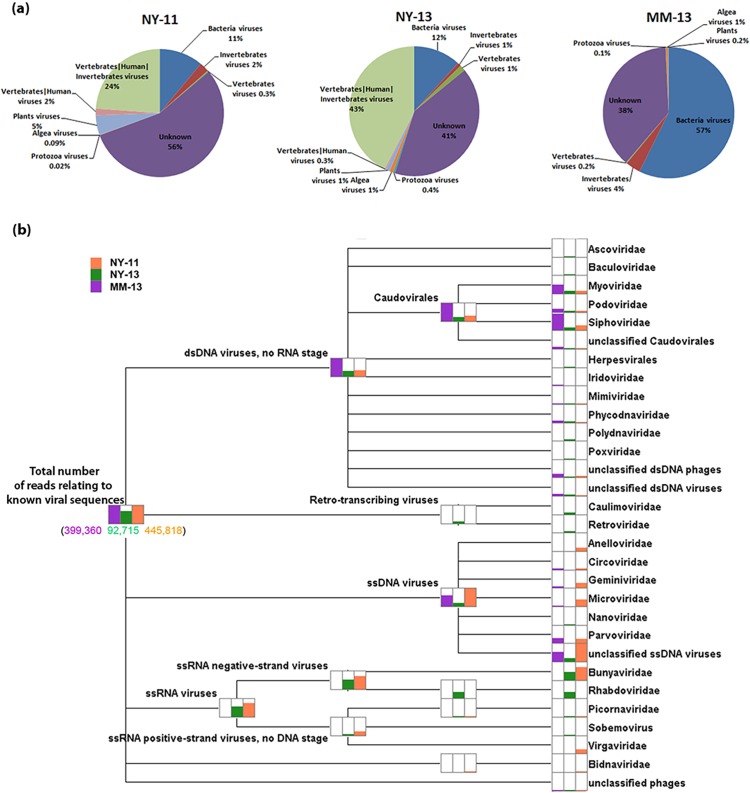
Taxonomic classification overview of metagenomic sequences from the three tick viromes.
(a) Classified by viral host. Breakdown of the viral sequences into seven categories: vertebrate-human-invertebrate, vertebrate-human, vertebrates, invertebrates, plants, algae, and protozoa viruses. (b) Classified by viral family. Viral metagenomic sequences were compared with the viral protein database in GenBank. Comparisons were performed with the BLASTx algorithm using an E-value cutoff 1e-04. The MEGAN5 program (http://ab.inf.uni-tuebingen.de/software/megan5/) was used for acceptance of the output of a BLAST enquiry based on the lowest-common-ancestor algorithm taxonomy analysis.